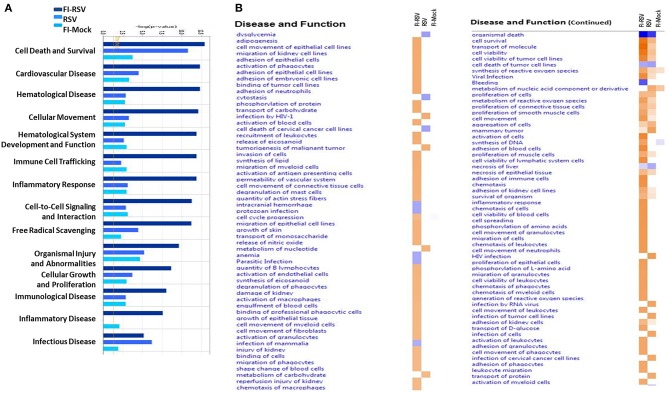
Predicted disease and functional outcomes from Ingenuity Pathway Analysis highlights the possibility of a hypercoagulation state. IPA downstream analysis results are displayed with the p-value of overlap (A) showing the likelihood that the disease and/or functional outcome occur. Those that gave a –log1.3 were considered significant (yellow line). Only the first 14 most highly predicted outcomes are displayed. (B) Heat map of the z-score (>2 or <-2) showing the degree of up-regulation or down regulation of the respective disease or functional annotations in each of the groups (n = 12).